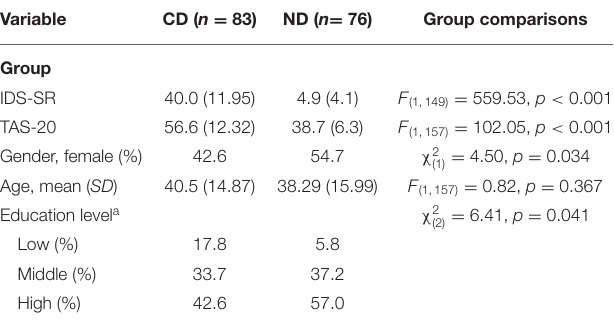
TABLE 1 | Group comparisons of the final sample on demographic variables and TAS-20 (total and subscale) scores [means and standard deviations ( SD )] including test statistics for the group